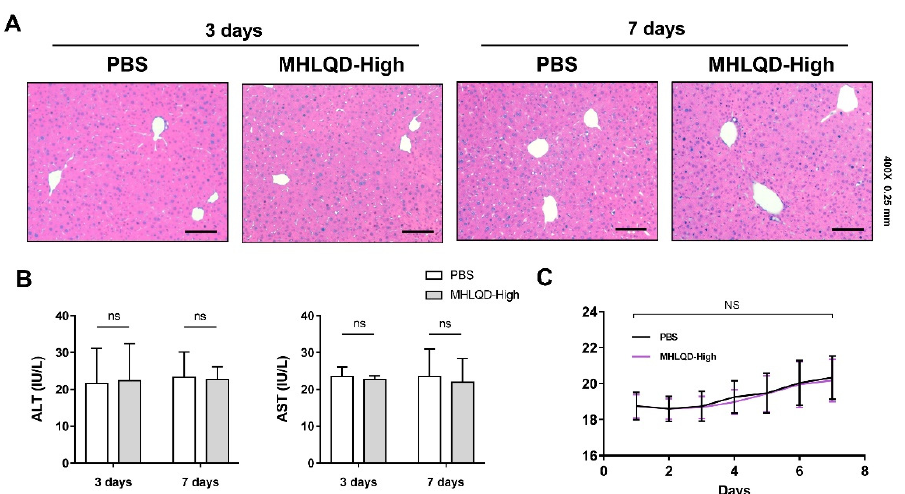
Figure 7. Short-term treatment of MHLQD did not show toxicity. The mice were randomly divided into (1) the control group, and (2) the MHLQD group. The mice were intragastrically administrated with MHLQD (81 g/kg) or the same volume (0.2 mL) of PBS twice a day. The mice were sacrificed on the third day or the seventh day. ( A ): The H&E staining of the liver section. Scale bar: 0.25 mm. ( B ): The liver function levels (ALT and AST) of the mice (n = 5). ( C ): The body weight curves of the mice (n = 5). Abbreviation: MHLQD: MaHuang-LianQiao-ChiXiaoDou decoction.